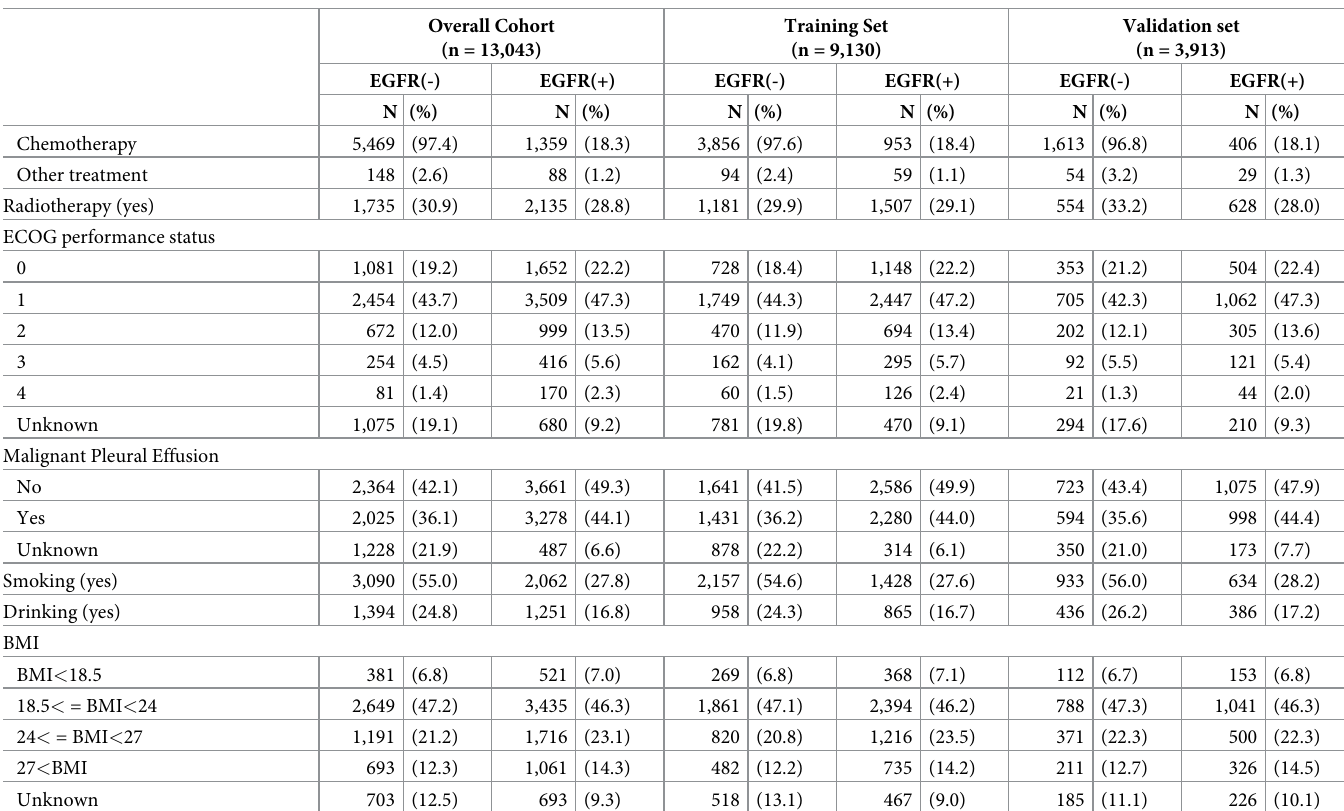
We compared the R 2 and AIC of different models with the null model by adding significant prognostic factors one at a time ( S1 Table ). The final nomogram model demonstrated the best fit and identified 13 variables for EGFR (+) and 12 variables for EGFR (-) that had strongest association with OS risk. BETAs of each variable were estimated and converted to a score. In the EGFR (+) group, the ECOG performance status had the highest BETA and was assigned 100 points on the scale (when ECOG performance score = 4), and the remaining variables were assigned a smaller number of points proportional to their effect